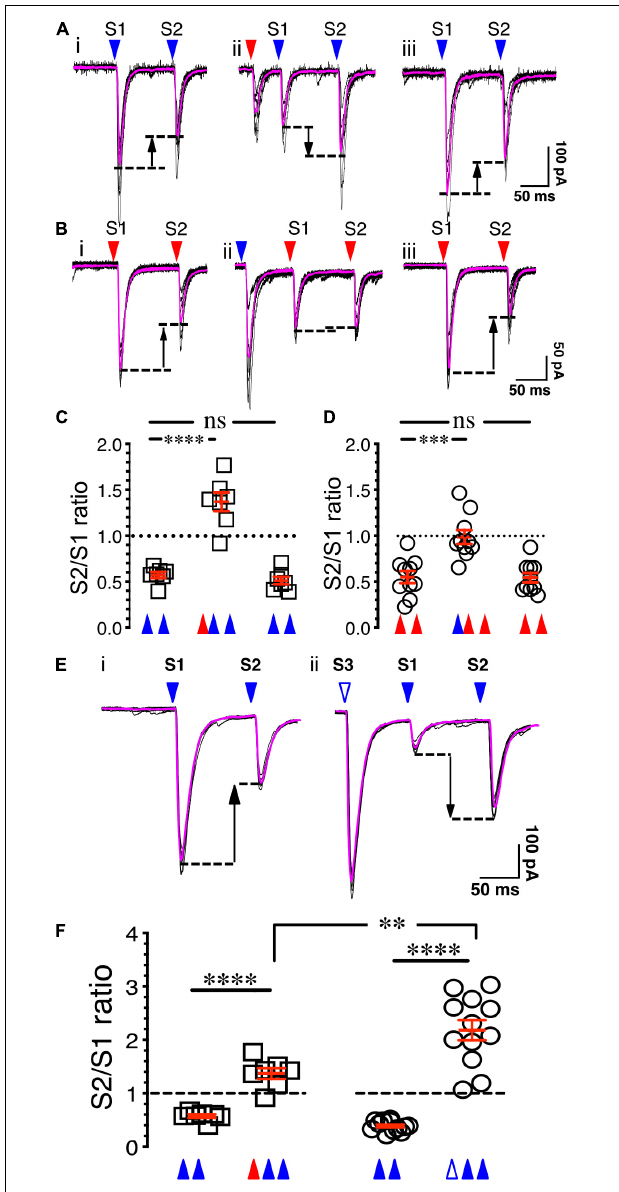
FIGURE 4 | Synaptic gating is a pre-synaptic phenomenon. (Ai) Eight overlaid traces of PFCx-EPSCs (blue arrowheads) evoked 100 ms apart (S1 and S2). (Aii) Same as in i with stimulation of the BLA afferents (red arrowhead) preceding PFCx-EPSCs. (Aiii) Shows in the same recording that paired pulse depression returned to control level when stimulation of BLA afferents was turned off. (B) Stimulation order was reversed from panel (A) . (C) Graph showing the switch from depression to facilitation following stimulation of BLA inputs ( n = 7). (D) Graph showing the loss of depression following stimulation of PFCx inputs ( n = 10). Note that the magnitude of the switch is not similar. (Ei) Eight overlaid traces of PFCx-EPSCs (blue arrowheads) evoked 100 ms apart (S1 and S2). (Eii) PFCx inputs were stimulated 70 ms before the PPR protocol (S3). Purple lines show average traces. (F) Graphs showing the switch from depression to facilitation when the PPR at cortical synapses is preceded by stimulation of the BLA (circles) or PFCx (squares) pathways ( n = 11). Average values in graphs are expressed as mean ± standard error (SEM). ∗∗ p < 0.01, ∗∗∗ p < 0.001, ∗∗∗∗ p < 0.0001. Purple traces show averaged EPSCs in panels (A,B,E) .